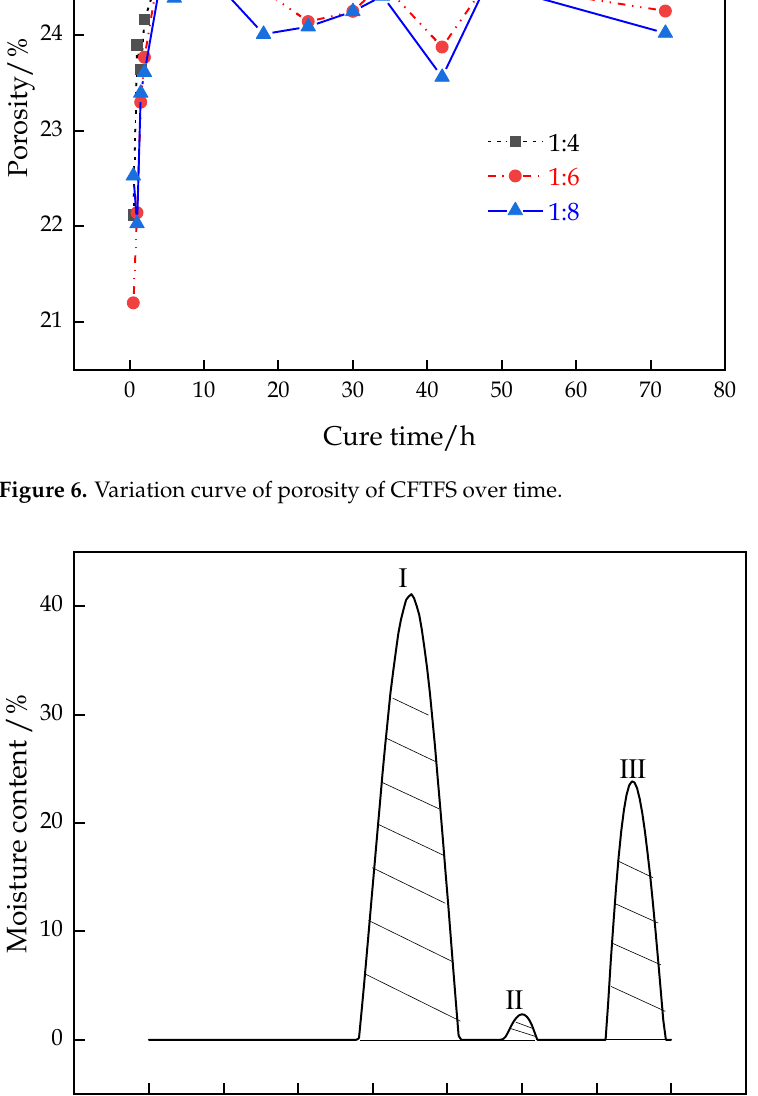
Figure 7. T2 spectral inversion curve.